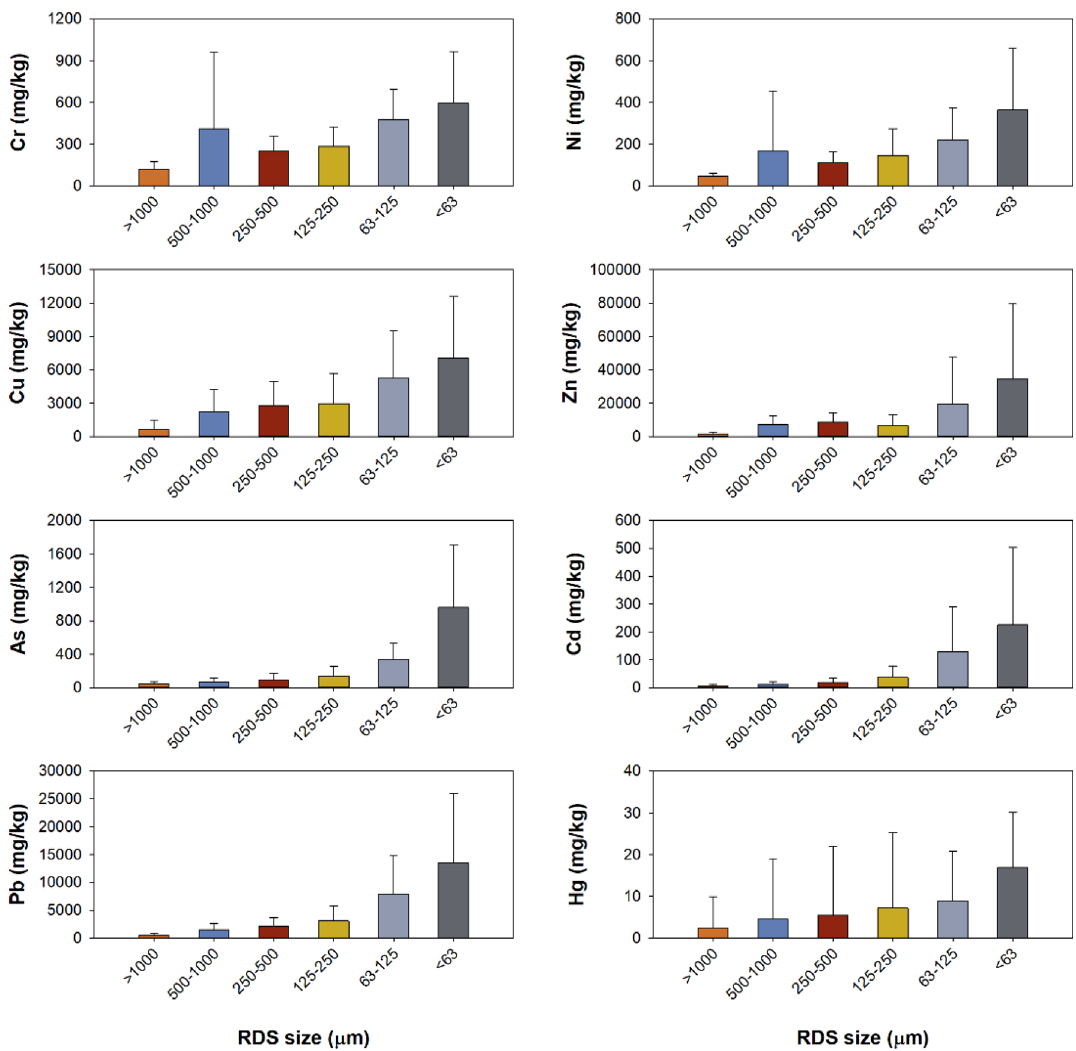
Figure 2. Comparison of mean PTEs concentrations (mg/kg) with standard deviation in the different sizes of road deposited sediments of this